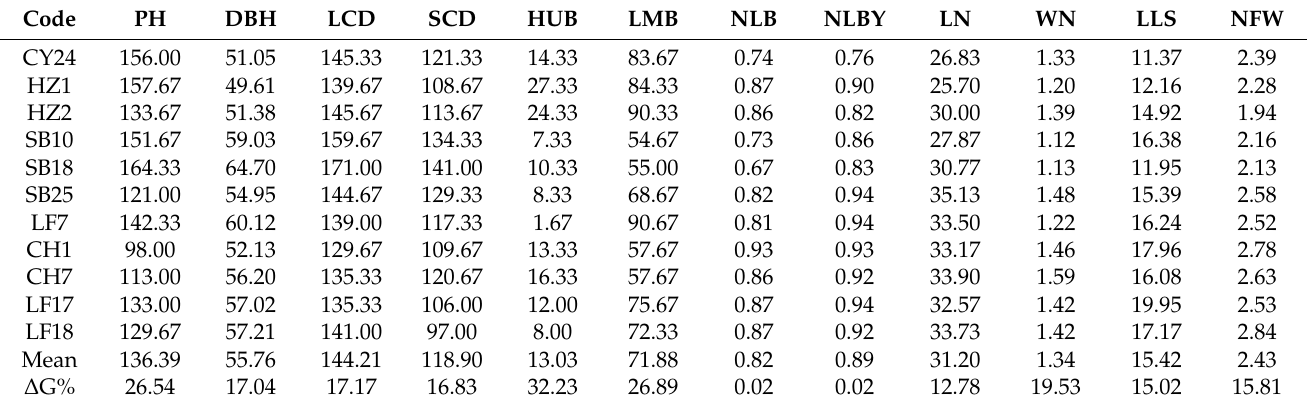
Table 5. The growth, form quality performance, and realized gains of superior families of P. yunnanensis .